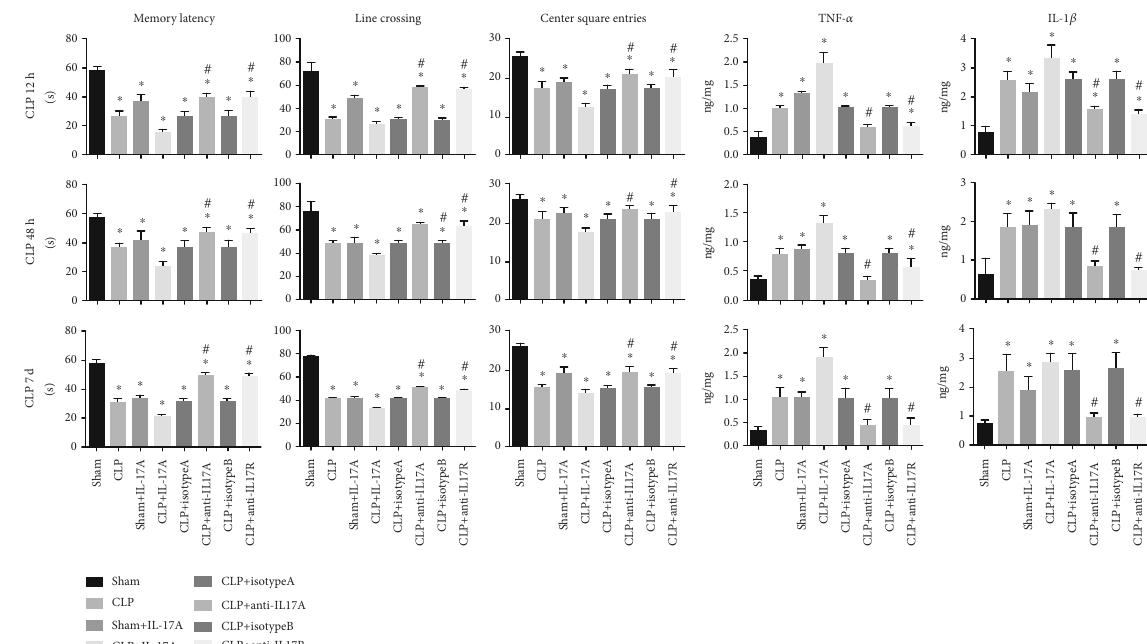
Figure 4: Behavior performance and neuroin fl ammation were determined following the modulation of the IL-17A/IL-17R pathway. Mice received i.c.v. injection of recombinant IL-17A (20 ng), anti-IL17A ab (2 μ g), anti-IL-17R ab (1 μ g), isotype control (isotypeA: IgG1 Ƙ 2 μ g, isotypeB: IgG2A 1 μ g), or saline. Samples were collected and analyzed at 12 h, 48 h, or 7 days post surgery. ∗ P < 0 : 05 vs. sham control; # P < 0 : 05 (CLP+anti-IL17A ab vs. CLP+isotypeA; CLP+anti-IL17R ab vs.